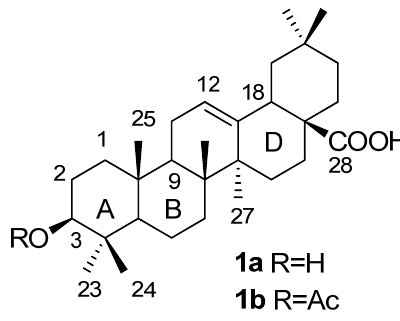
Figure 1. Structures of OA ( 1a ) and 3 β -acetoxyl-OA ( 1b